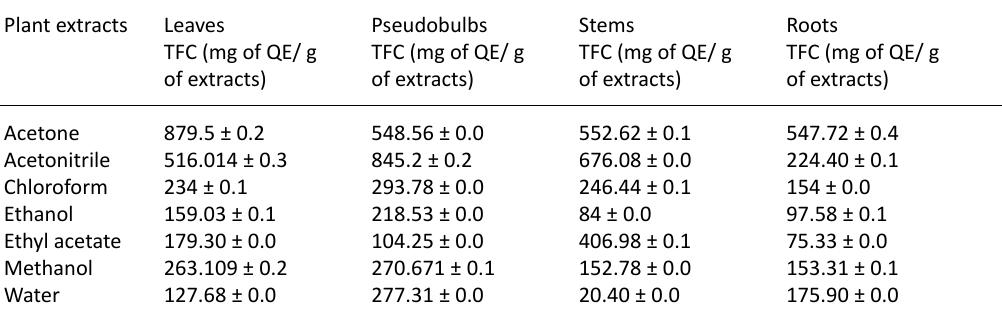
table 6. Total flavonoid Content (TFC) of different parts of P. maculata by Aluminium Chloride method Plant